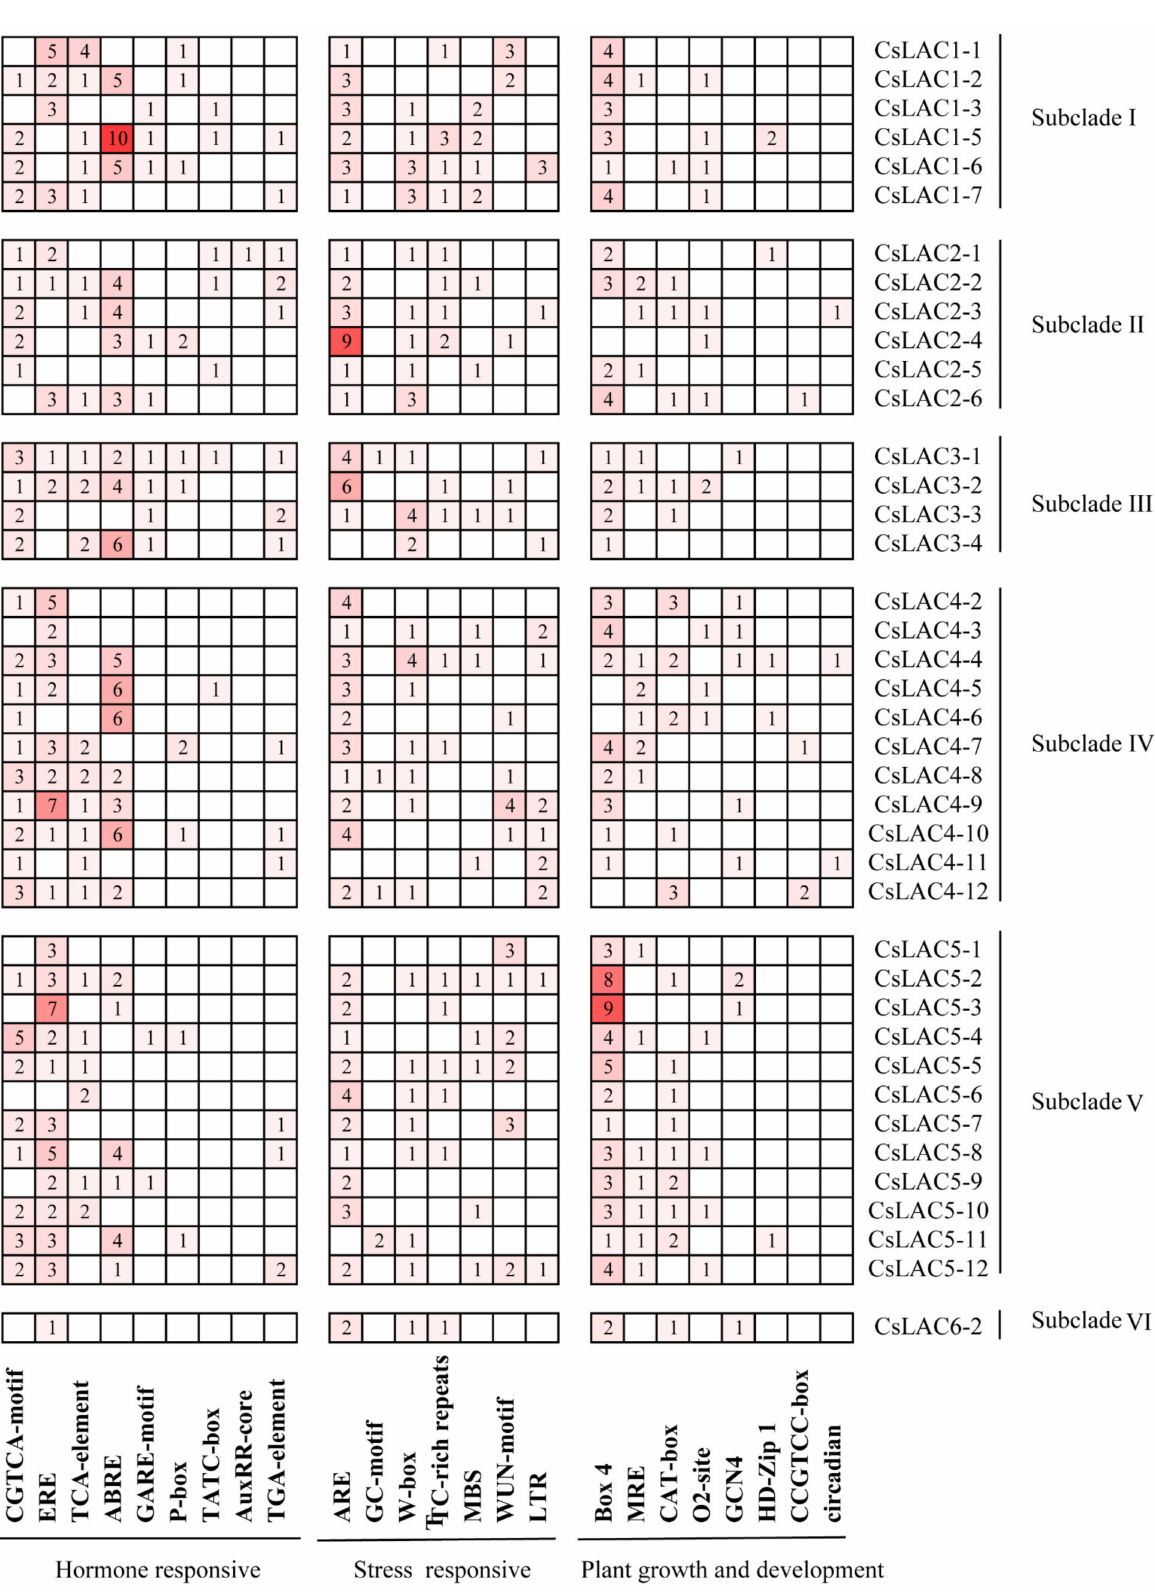
Figure 4. Analysis of cis -elements in CsLAC promoters. The numbers of cis -elements existed in the promoter sequences of CsLAC s were identified involving in three types biological processes. The depth of red colour indicates the quantity of cis -elements of CsLAC